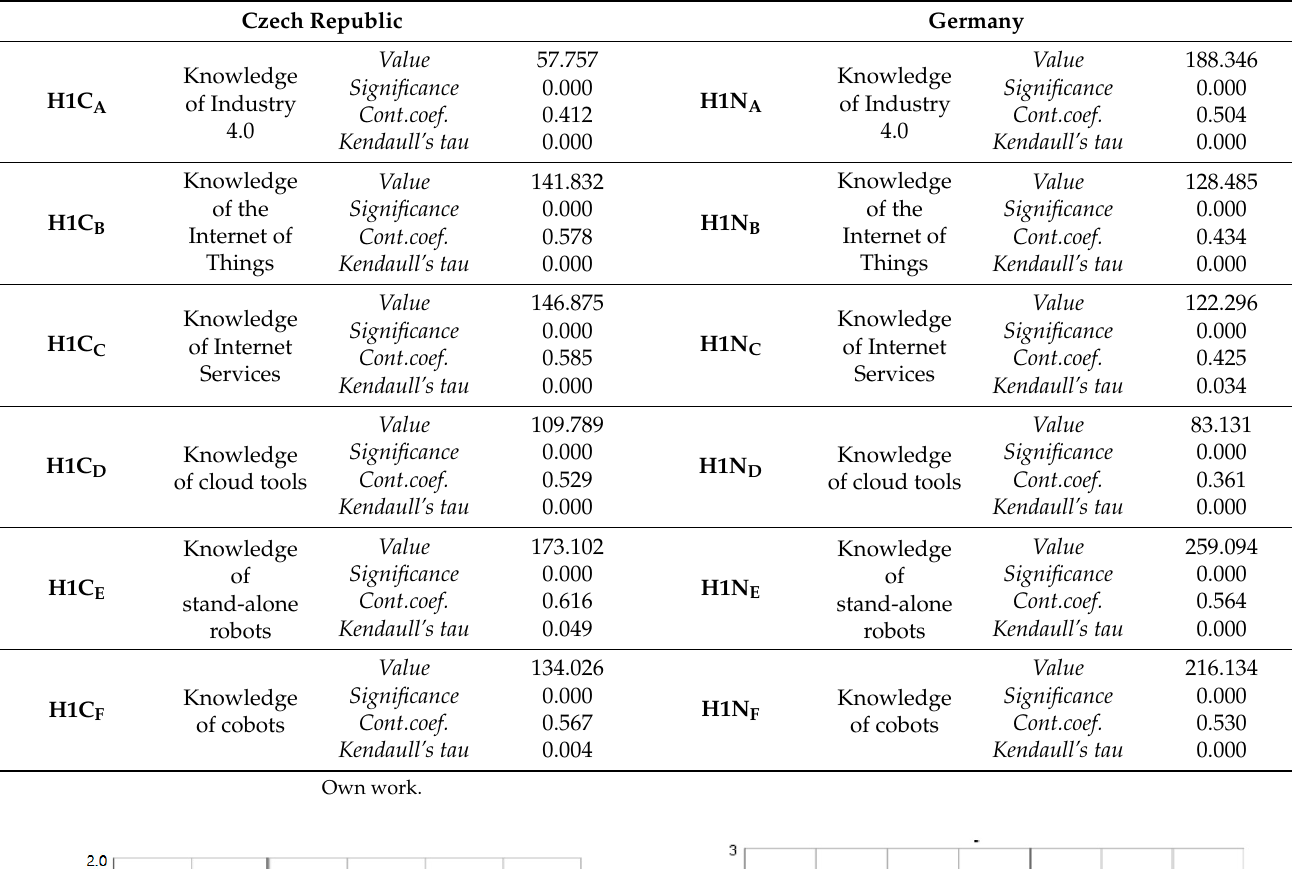
Table 1. Gained results for sub-hypotheses H1—expectations of changes in professions.